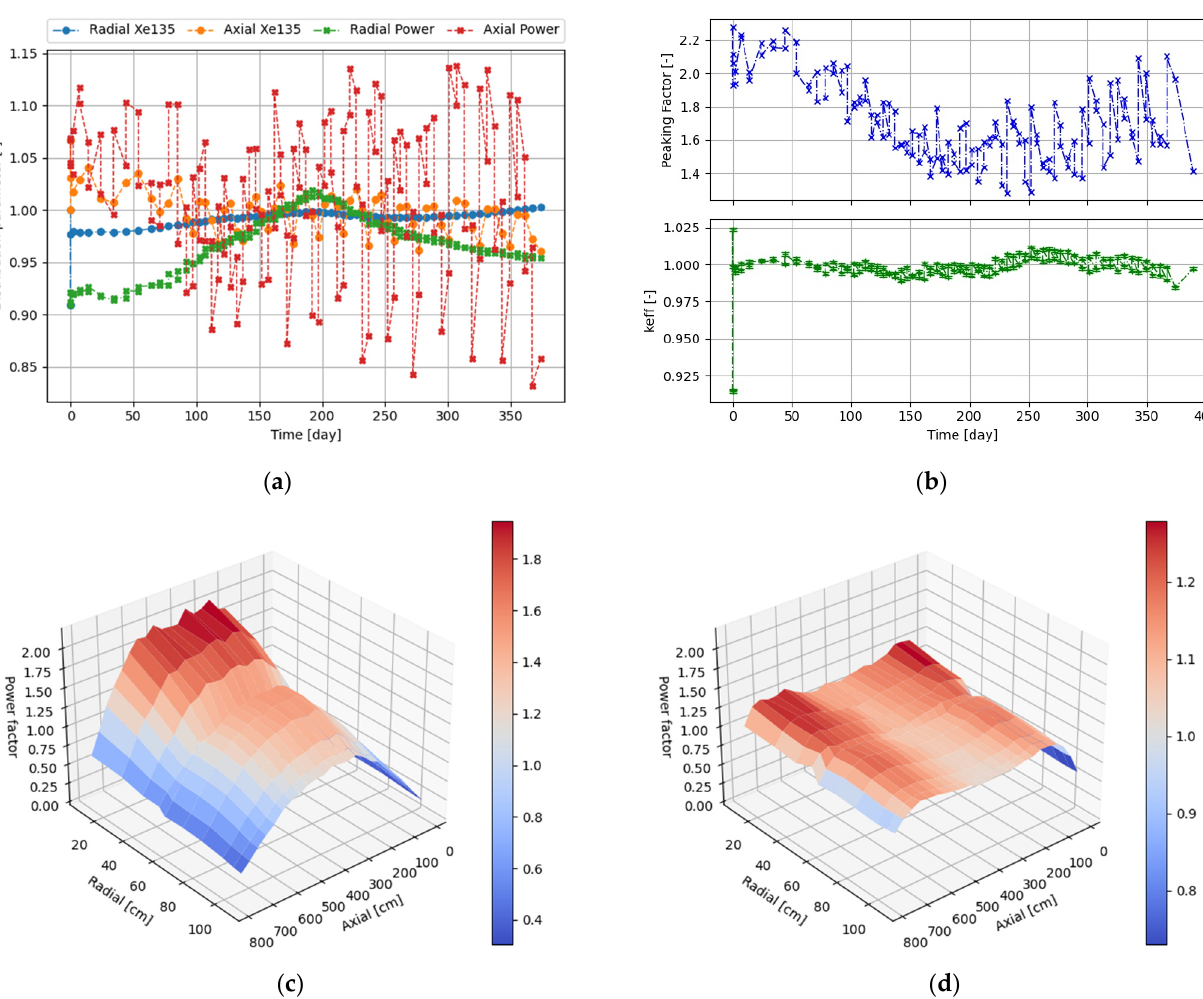
Figure 6. Result of operation strategy St_opt, with volumetric shares of the control rod layers (starting from outermost) 45%, 31.6%, 14.3%, and 7.1%: ( a ) distribution parameters; ( b ) total peaking factor (top) and evolution of Keff (bottom); ( c ) power profile after operation of the control rods on day 20; ( d ) power profile after operation of the control rods on day 260.